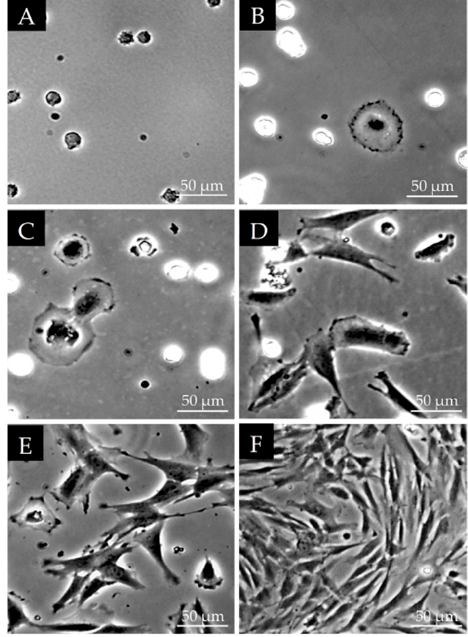
Figure 1. Changes in DPSC morphology at different stages of cell adhesion after passaging with trypsin/EDTA: 5 min ( A ), 1 hour ( B ), 2 hours ( C ) 8 hours ( D ) 21 hours ( E ) and 3 days ( F ). all of the photomicrographs were taken at the same magnification under a phase contrast microscope. The scale bars indicate 50 µm.